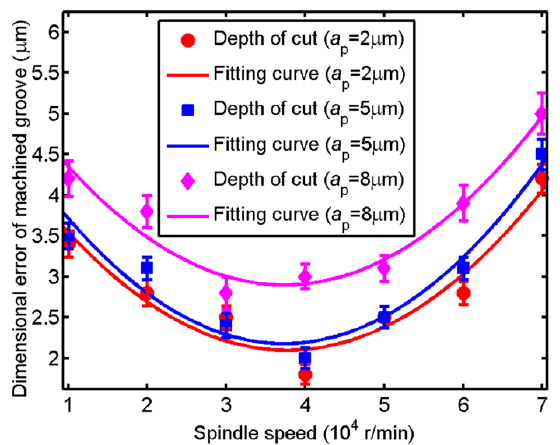
Figure 10. The change of dimensional error of machined groove with spindle speed under different depth of cut.